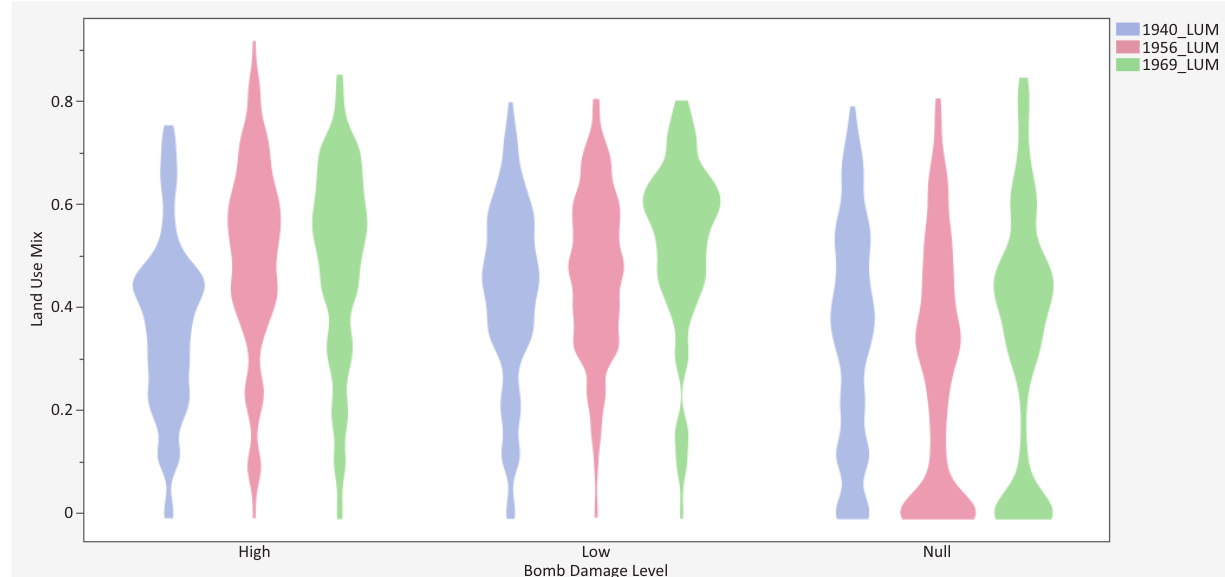
Figure 8. Violin plots of LUM: LUM a index for three bomb damage levels for three years: 1940, 1956,